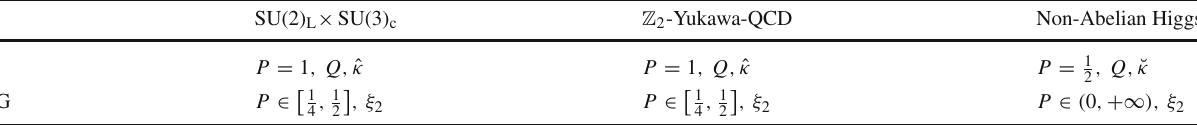
space of solutions. In the FRG schemes, we refer to the setup where the same regulator is used for all fields, as detailed in Sect. 6.1. For the most general model we specify the SM matter content in the flow of the gauge and Yukawa